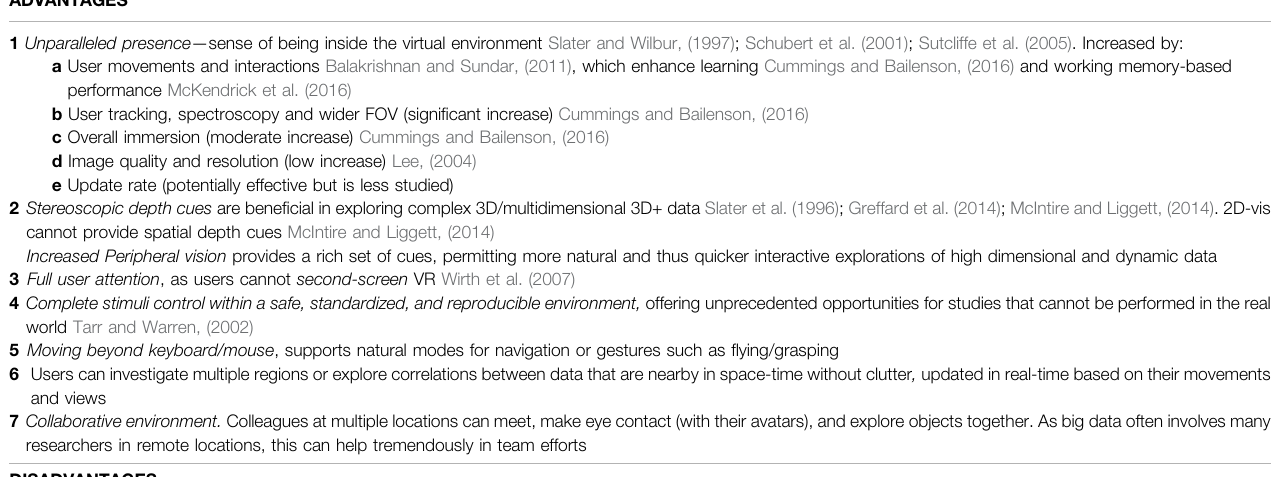
TABLE 2 | Advantages and Disadvantages of VR technologies.